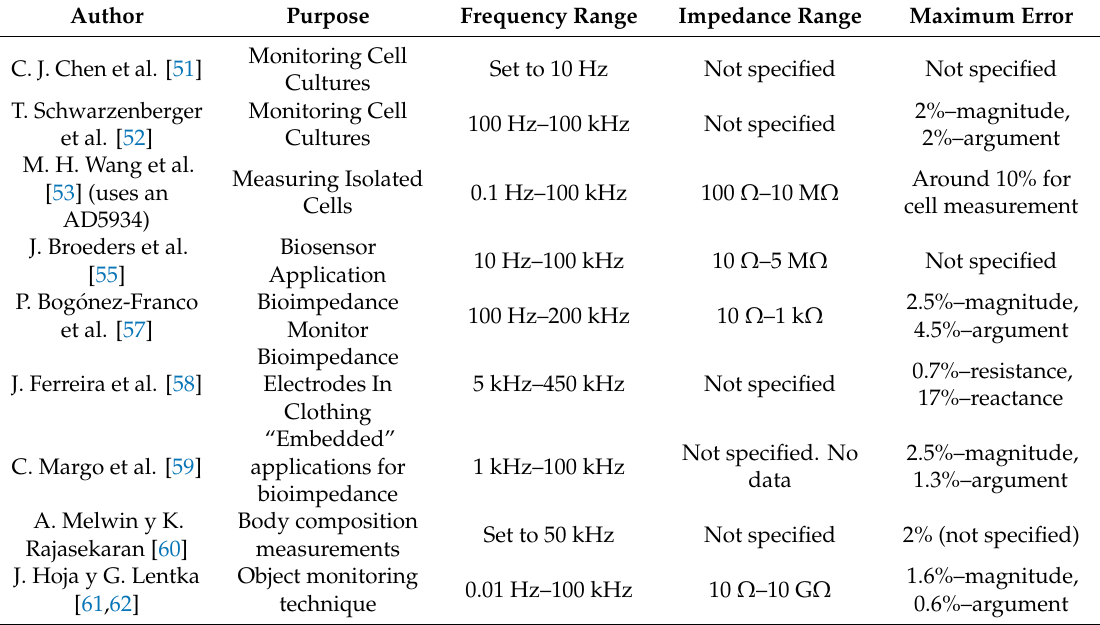
Table 1. List of electrical impedance meters based on the SoC AD5933 (taken from